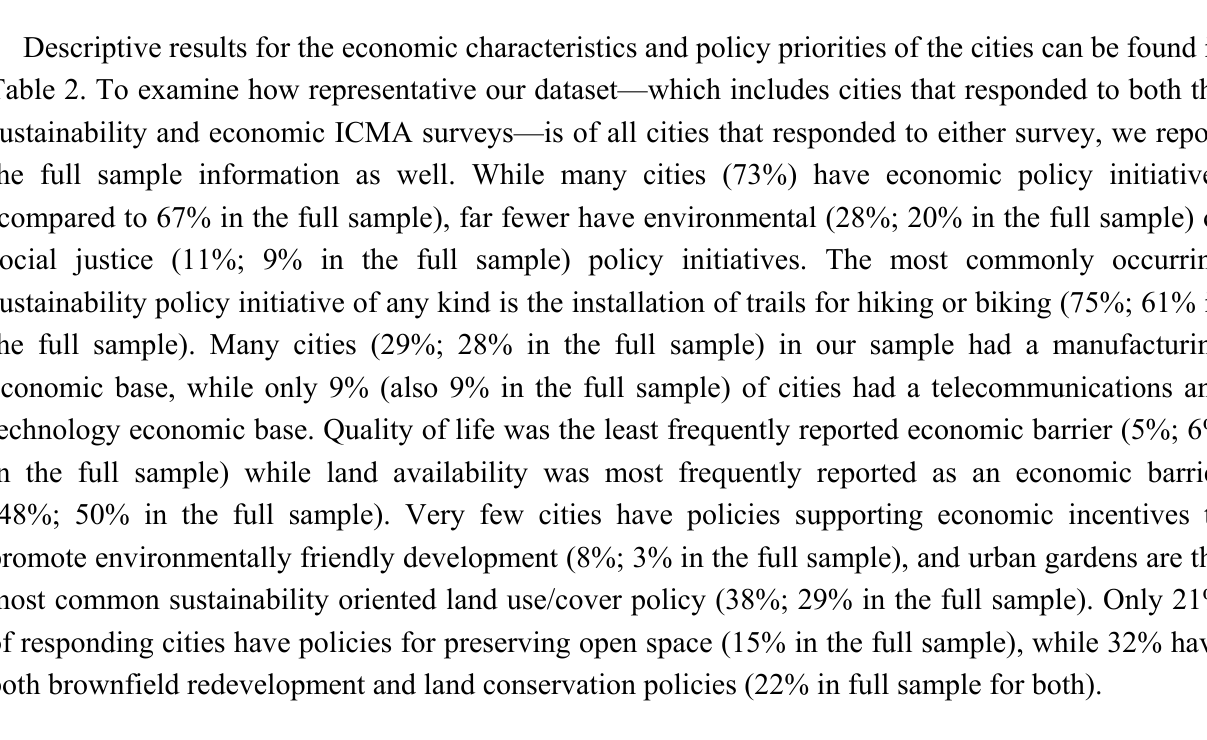
Table 2. Survey results, showing the average and std. deviation of responses from all cities in our sample (n =